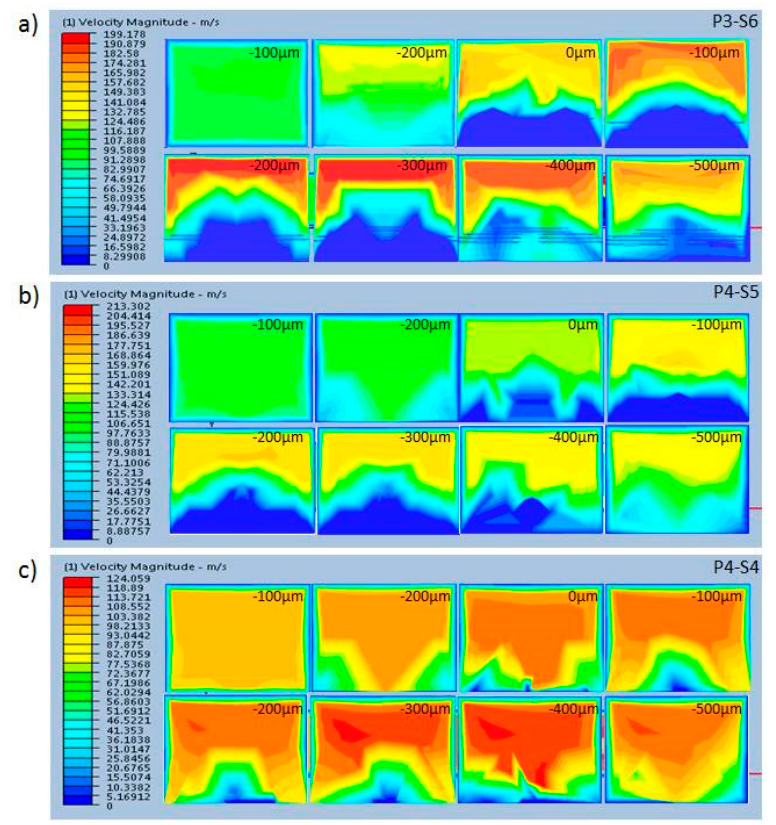
Figure 4. Schematic showing the distribution of velocity magnitude along the x-axis. ( a ) P3-S6, ( b ) P4-S5, and ( c ) P4-S4.